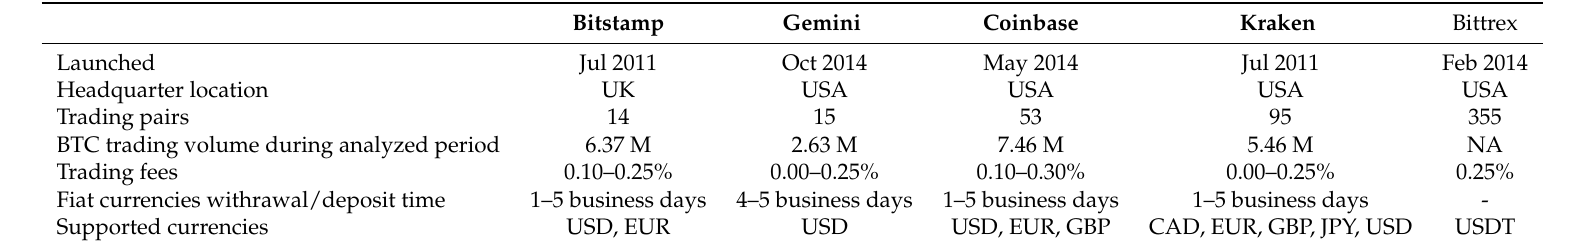
Table 2. Bitcoin exchange